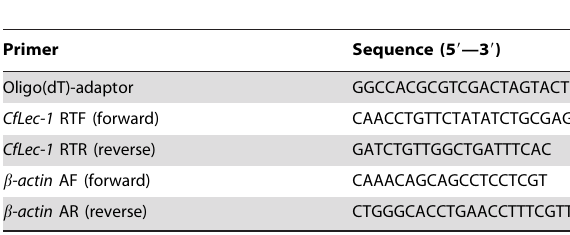
Table 1. Primers used in the present